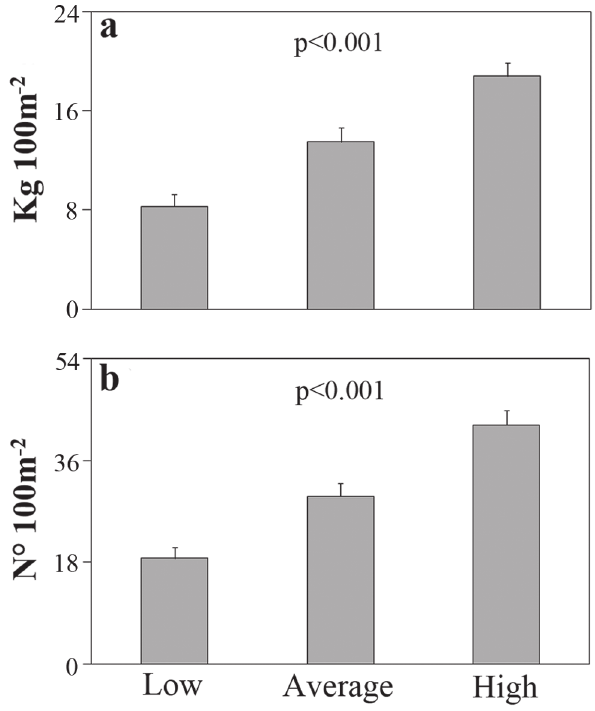
Fig. 4. Biomass ( a ) and Abundance ( b ) of C. fulva according to structural complexity of reef substrate at Trindade Island, Brazil. Error bars indicate standard error